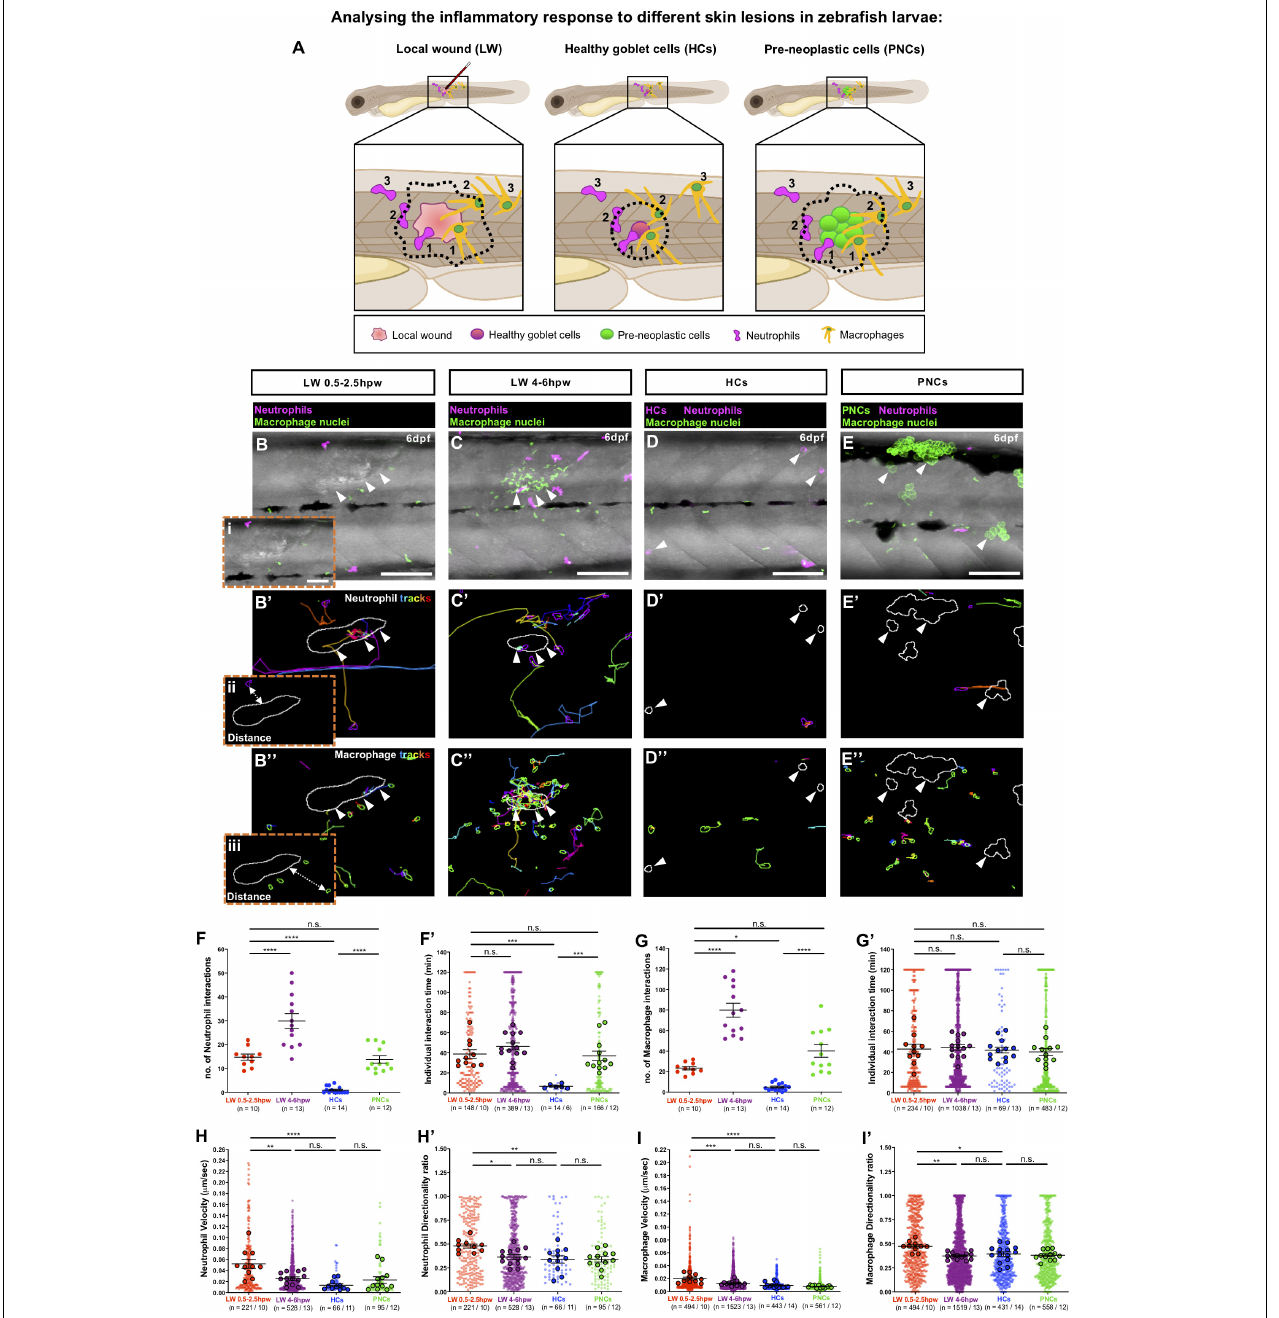
FIGURE 1 | Analysing the inflammatory response to different skin lesions in zebrafish larvae. (A) Schematic to illustrate our cancer-wound comparison studies showing the region (black box) to be imaged in (B–E) , for neutrophils (magenta) and macrophages (orange) as they respond to the different skin lesions: local wound (LW), healthy RFP-expressing goblet cells (HCs) or pre-neoplastic GFP-expressing goblet cells (PNCs); dotted lines indicate the “close proximity” zone from margins of each lesion type; 1 and 2 indicate immune cells in contact with the lesion or within “close proximity”, respectively, and 3 indicates immune cells outside this zone. (B–E) Multi-channel confocal movie frames of 6 dpf flank wounded Tg( lyz:DsRed;mpeg1:nls-Clover ) (B,C) , unwounded control Tg( kita:mCherry; lyz:DsRed;mpeg1:nls-Clover ) (D) or cancerous Tg( kita:HRASG12V-GFP;lyz:DsRed;mpeg1:nls-Clover ) (E) larvae prior to analysis of neutrophil (magenta) or macrophage (green nuclei) behaviour and their interactions with the respective skin lesions (white arrowheads). (B’–E’,B”–E”) Post-software images of the same larvae showing neutrophils (magenta) (B’–E’) or macrophage nuclei (green) (B”–E”) and their tracks in the vicinity of the lesion (white lines indicate lesion margins). (i–iii) Higher magnification views from (B,B’,B”) showing the “cell-to-cell” distance between neutrophil cytoplasmic (ii) or macrophage nuclear (iii) margins to lesion margins. (F,G,F’,G’) Graphs showing number and duration of neutrophil-lesion (F,F’) and macrophage-lesion (G,G’) interactions. (H,I,H’,I’) Graphs showing velocity and directionality ratio of neutrophils (H,H’) and macrophages (I,I’) quantified at the lesion site. Scale bars = 100 µ m in (B–E) , 50 µ m in (Bi) .